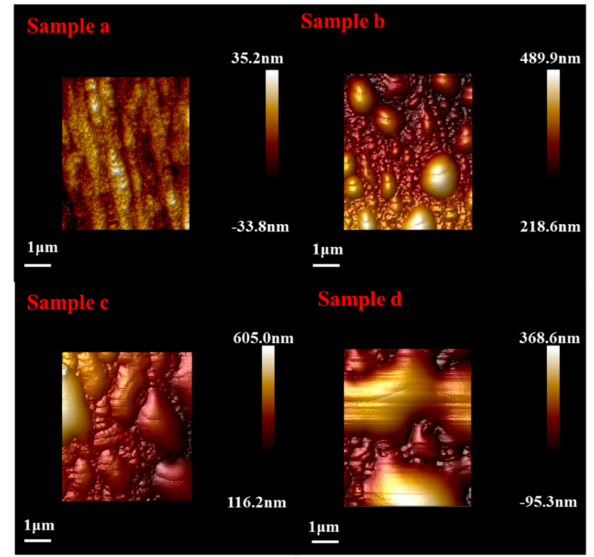
Figure 5. AFM topology of pristine BOPP film and corona BOPP film for di ff erent samples.